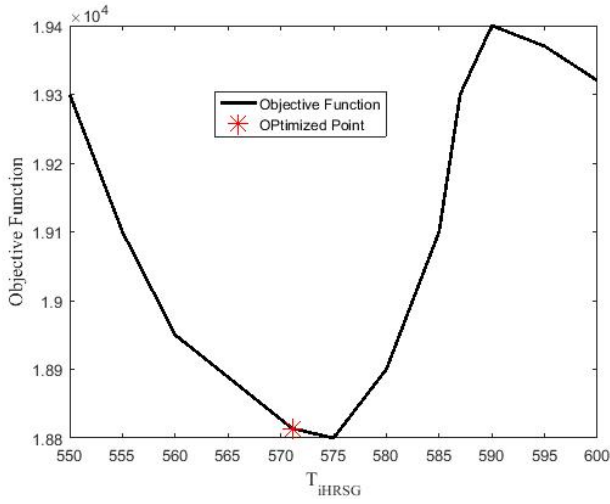
Figure 5. Variations in the objective function with the T iHRSG.